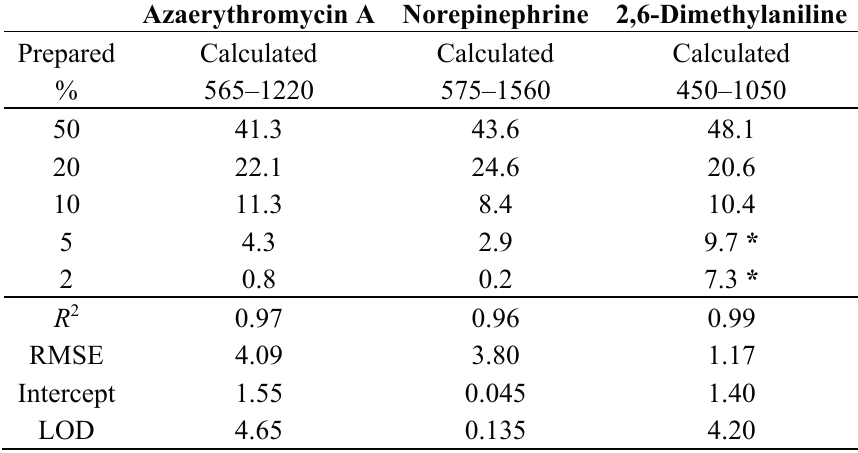
Table 2. Prepared and calculated percentages of degradants mixed with their corresponding drug determined using Raman spectra. Spectral regions are indicated.